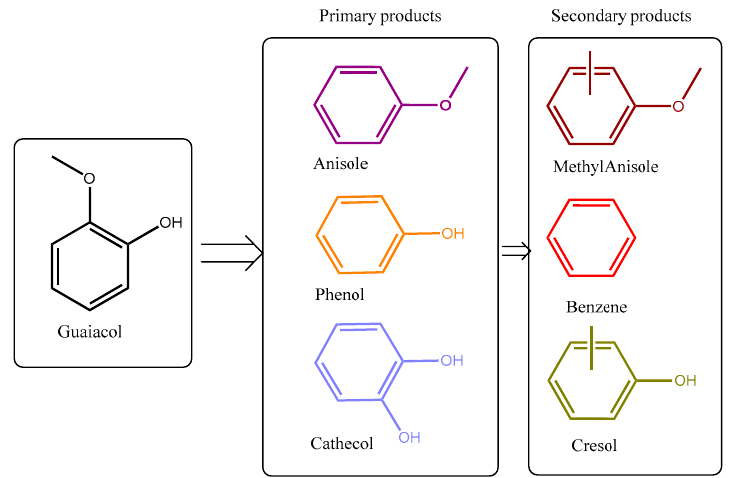
Figure 10. Main product obtained from guaicol HDO over Re-based catalysts.